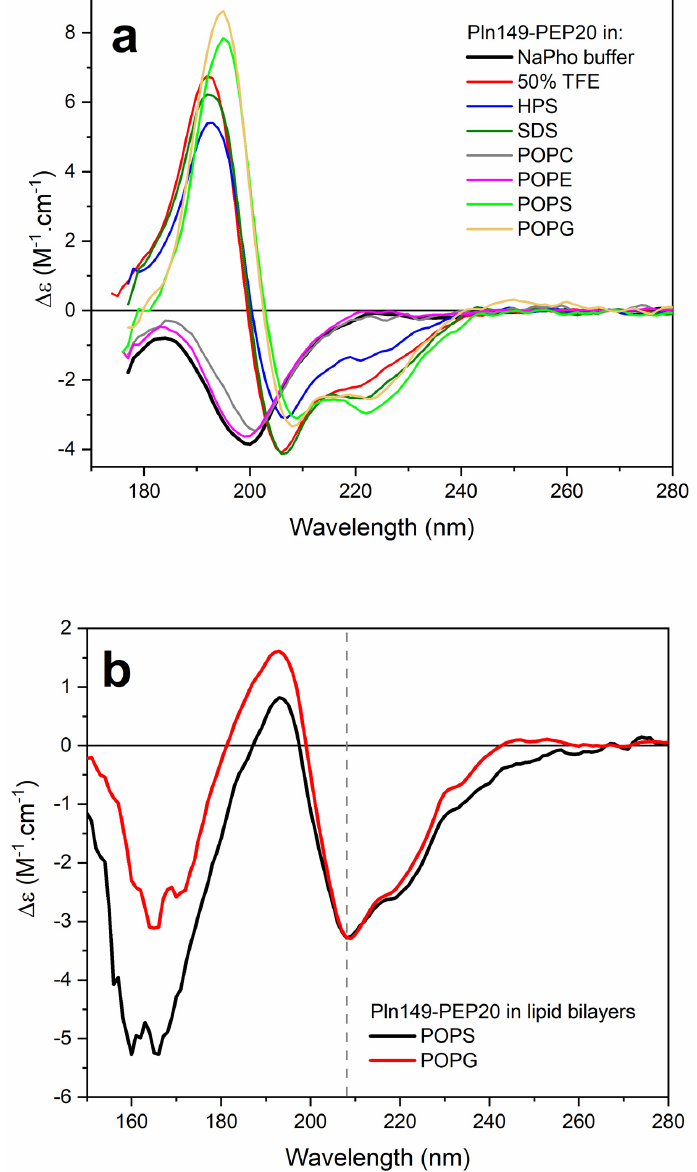
Figure 5. ( a ) SRCD spectra of Pln149-PEP20 in 10 mM sodium phosphate buffer pH 7 (black), 50% TFE (red), in the presence of the surfactants sodium dodecyl sulfate (SDS, olive) or N − hexadecyl − N − N’ dimethyl − 3 − ammonia − 1 − propane − sulfonate (HPS, blue), or vesicles of POPC (gray), POPE (magenta), POPS (green), and POPG (orange), at a 1/50 peptide-to-lipid molar ratio. ( b ) o-SRCD spectra of PEP20 in lipid bilayers of POPS (black) and POPG (red). Distinct model membranes were employed to investigate the binding of peptide Pln149-PEP20 to lipid systems in aqueous solutions and oriented lipid bilayers. The pep- tide assumed a stable α -helical structure in the presence of negatively charged or zwitter- ionic surfactants. In an aqueous solution, no conformational changes in Pln149-PEP20 were observed in the presence of zwitterionic large unilamellar vesicles (LUVs) of 1-pal- mitoyl-2-oleoyl-phosphocholine (POPC) and 1-palmitoyl-2-oleoyl-phosphoethanolamine